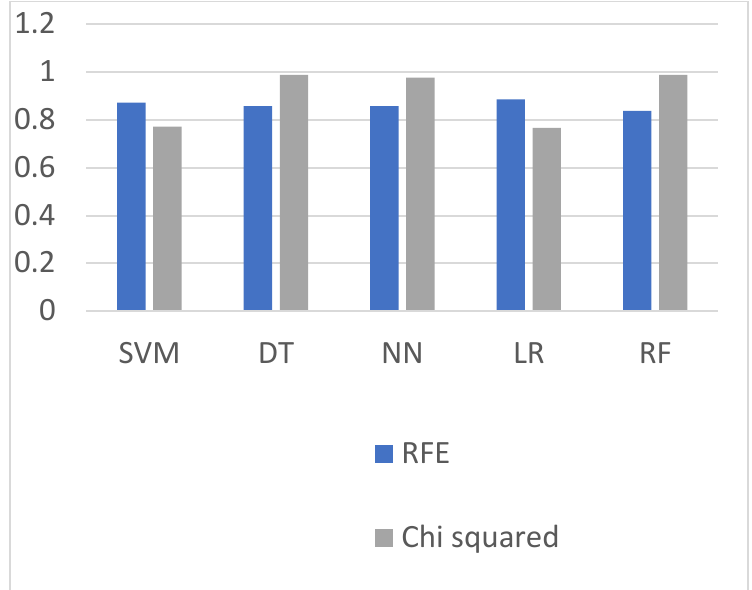
Figure 19. Accuracy using active risk model.